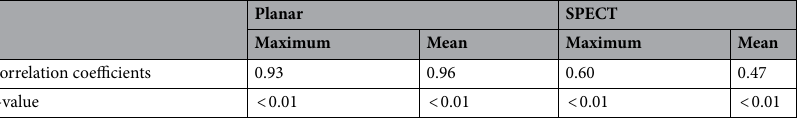
Table 1. The relationship between the intensity and the actual radiation dose. SPECT single-photon emission computed tomography.